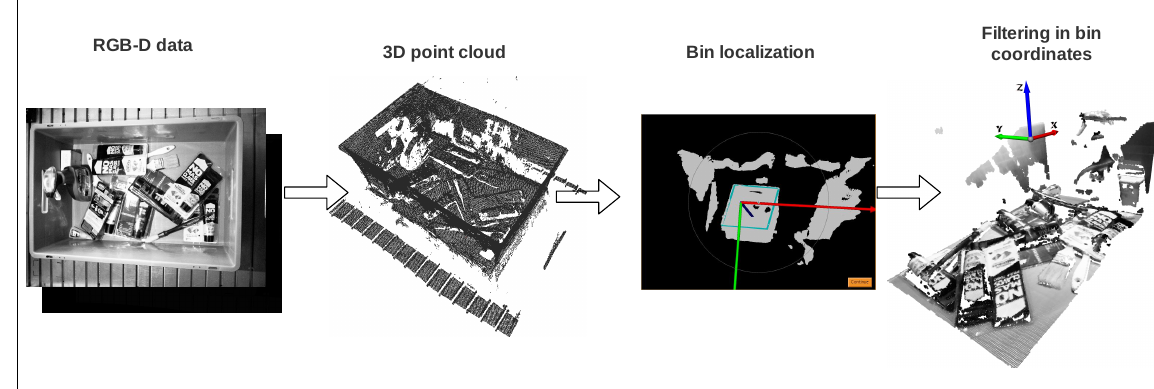
Figure 5. Data preprocessing